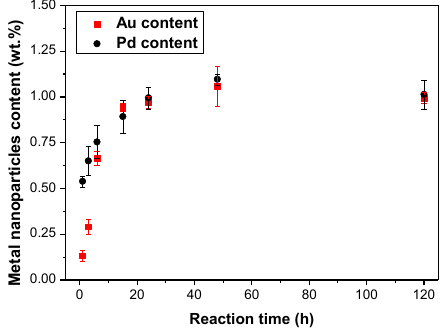
Figure 3. Au and Pd content (wt.%) measured by Inductive Couple Plasma-Optical Emission Spectroscopy (ICP-OES) in the treated ME / PDMS / Au and ME / PDMS / Pd foams obtained after di ff erent immersion times in 0.35 mg / mL of HAuCl 4 and 0.50 mg / mL of Na 2 PdCl 4 in ethanol,